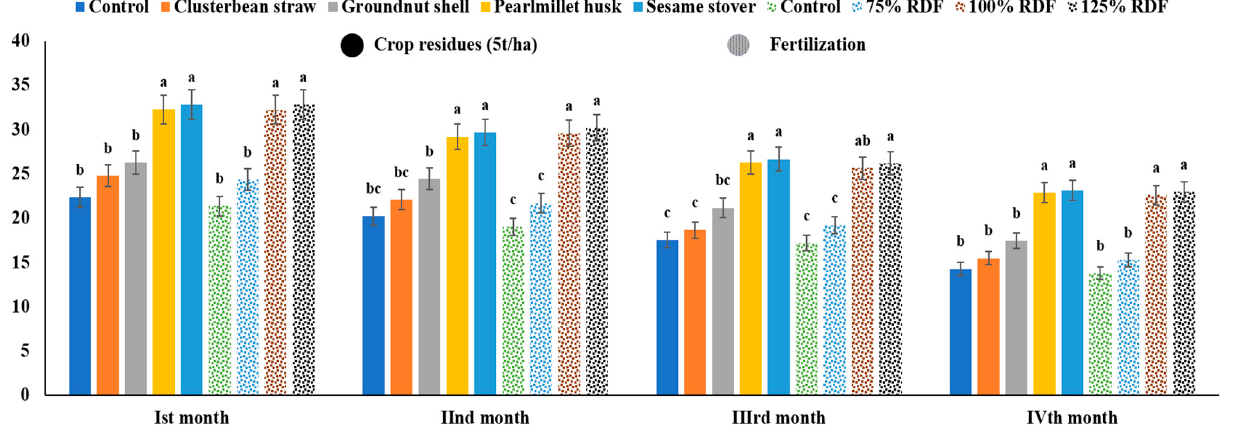
Figure 2. Effect of crop residues and fertilization on microbial biomass nitrogen (µg g − 1 ) at first, second, third, and fourth month after sowing. In this figure, the values followed by different lowercase letters indicate no significant difference ( p > 0.05) by Duncan’s multiple range test (DMRT).